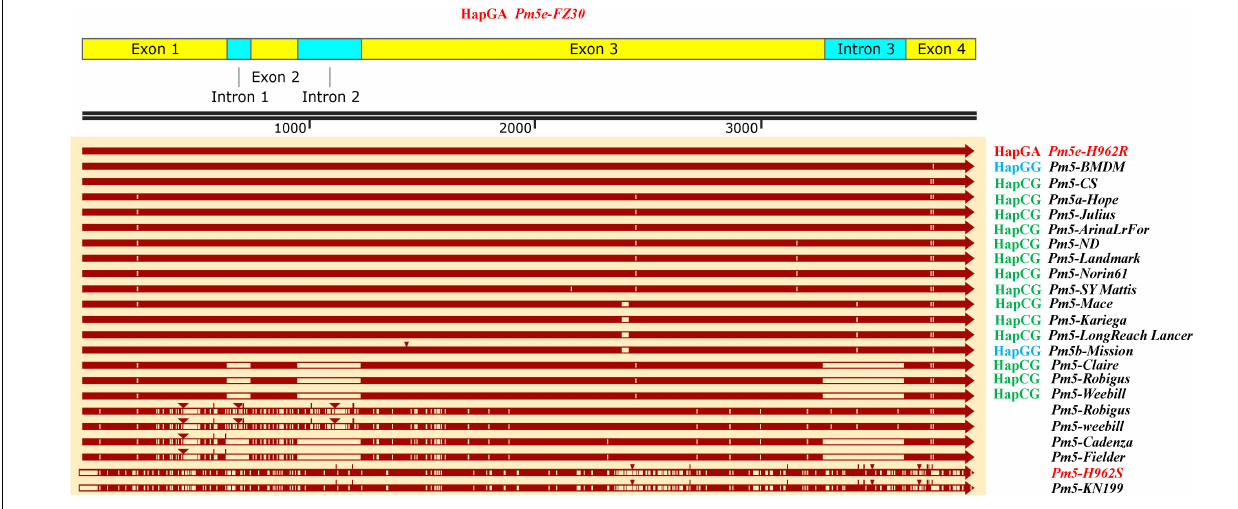
FIGURE 6 | Sequence alignment of Pm5e from different genotypes.